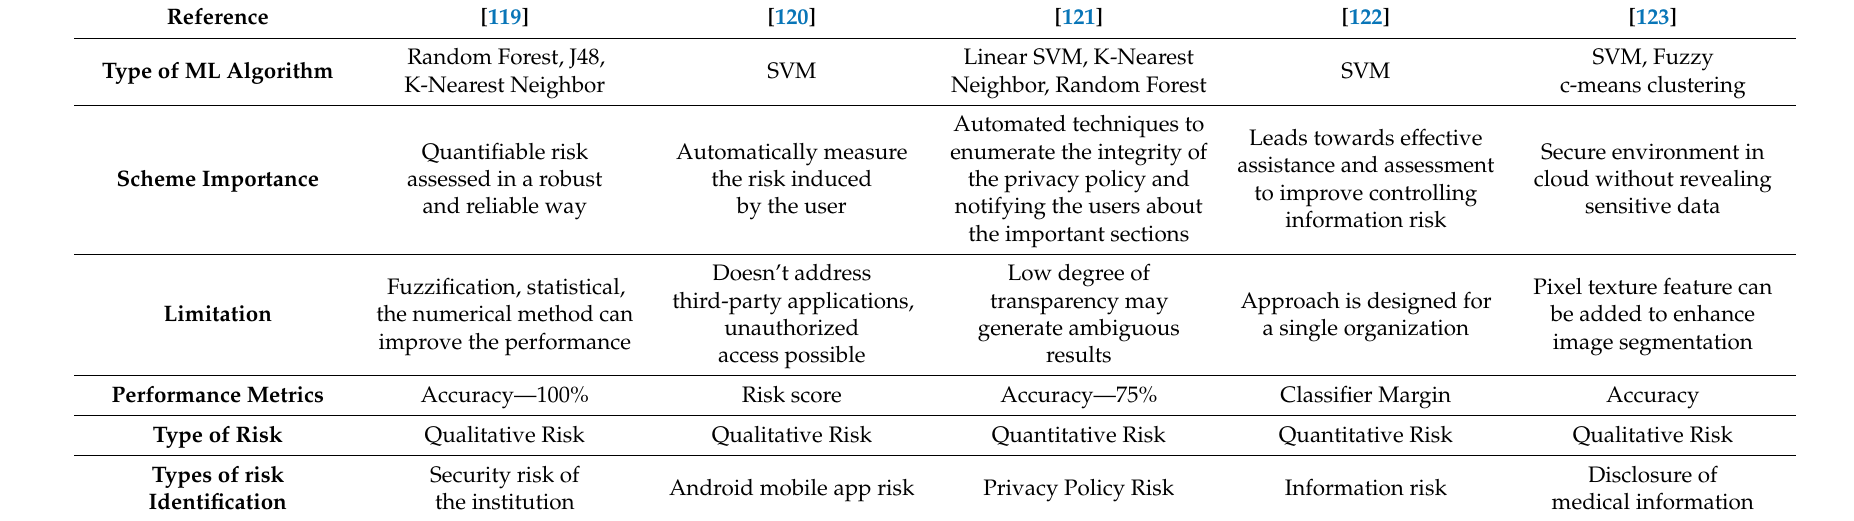
Table 9. Review of risk assessment schemes.